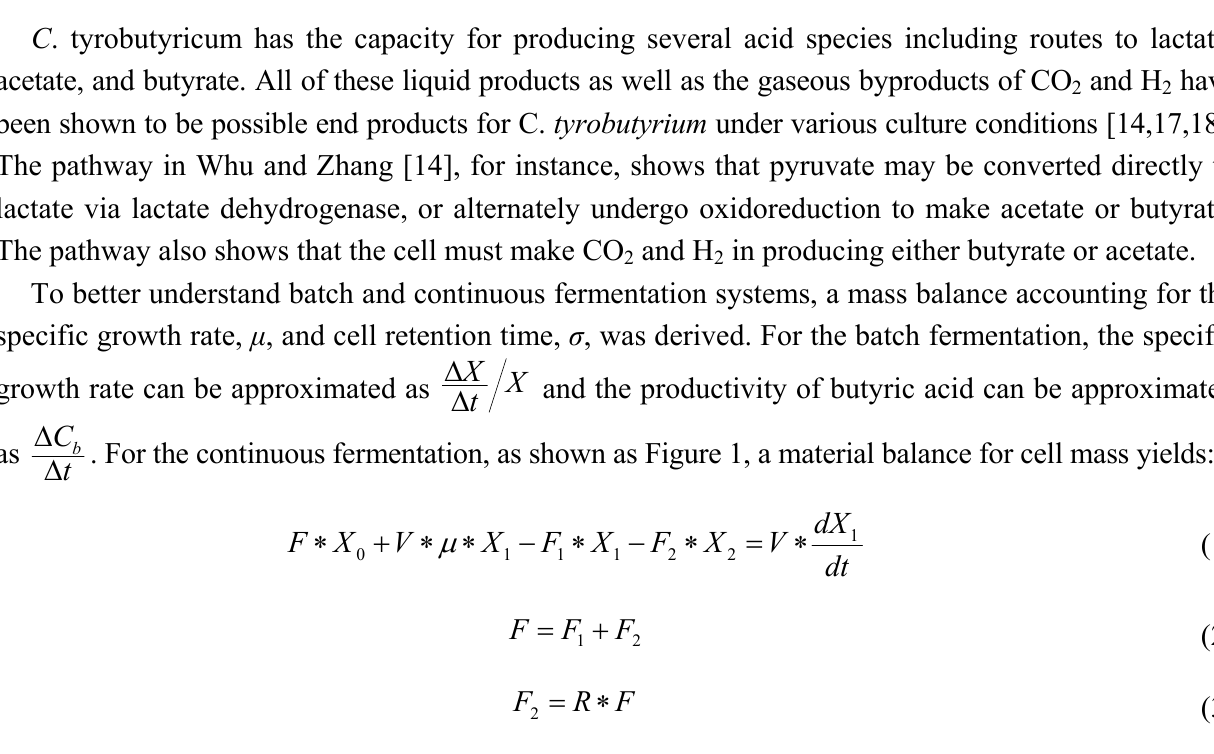
Figure 1. Schematic diagram for mass balance of continuous fermentation with cell recycle by C. tyrobutyricum